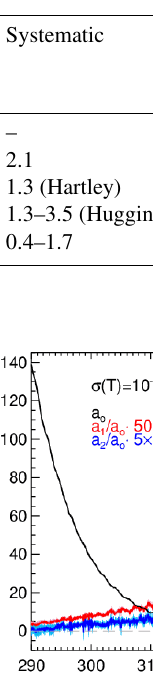
Table 6. Summary of uncertainties for Hearn, BP, BDM, and SG ozone cross sections.